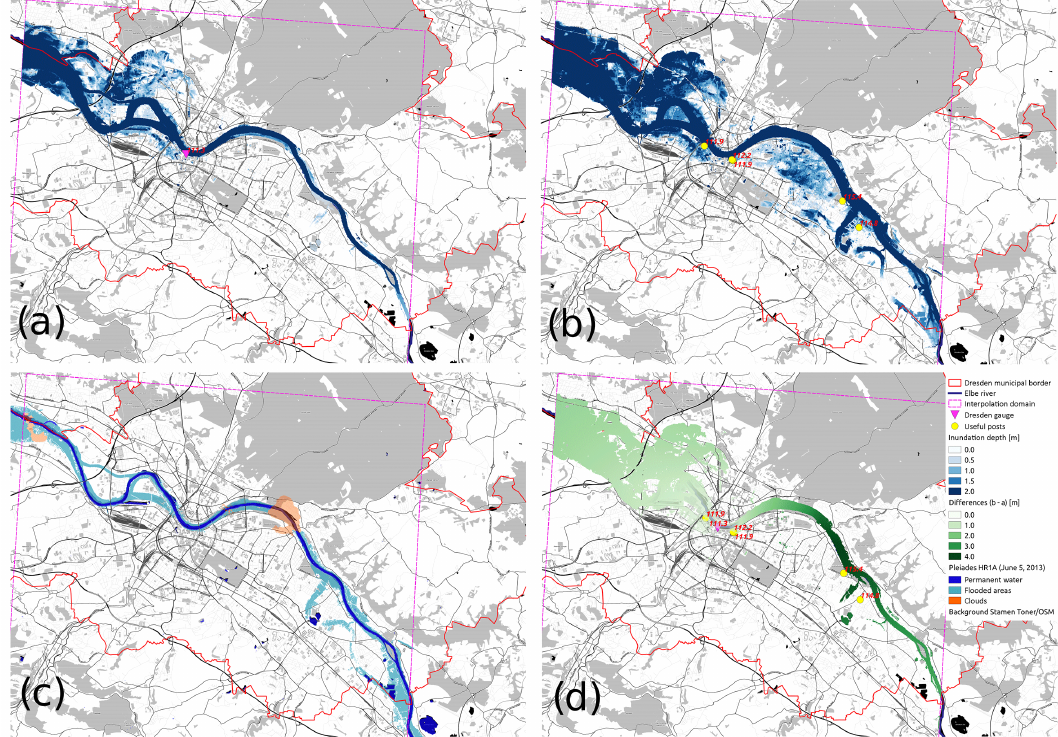
Figure 6. Inundation maps and inundation depths derived from online water level observations (a) and social media content (b) ; inundated area derived from the reference remote sensing flood footprint (c) ; and differences between inundation depths for overlapping areas in scenarios (a) and (b) (panel d